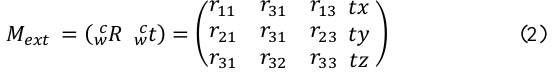
Figure 2. (A) Grid mission flight plan for the drone survey and (B) distribution of 30 GCPs across the field